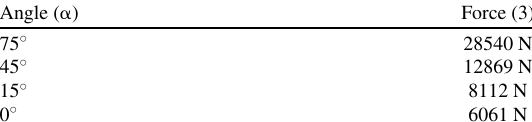
Table 2 Values of maximum force (3) that bone can support during falling or jumping without muscle failure, in four different (cid:2) positions, where (cid:2) is the angle formed by the axis of the humerus and the horizontal plane, see Fig. 5